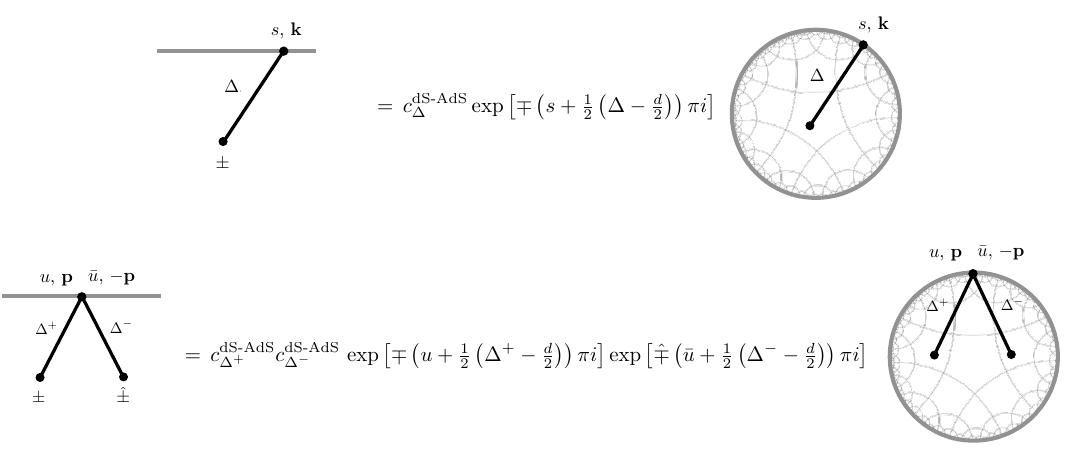
Figure 4. At the level of the Mellin-Barnes representation the relation between bulk-to-boundary propagators and harmonic functions in EAdS and the in-in formalism of dS amounts to a multipli- cation by a phase, which implements the Wick rotations (2.13), and by a constant c dS-AdS accounts for the change in two-point function coefficient from EAdS to